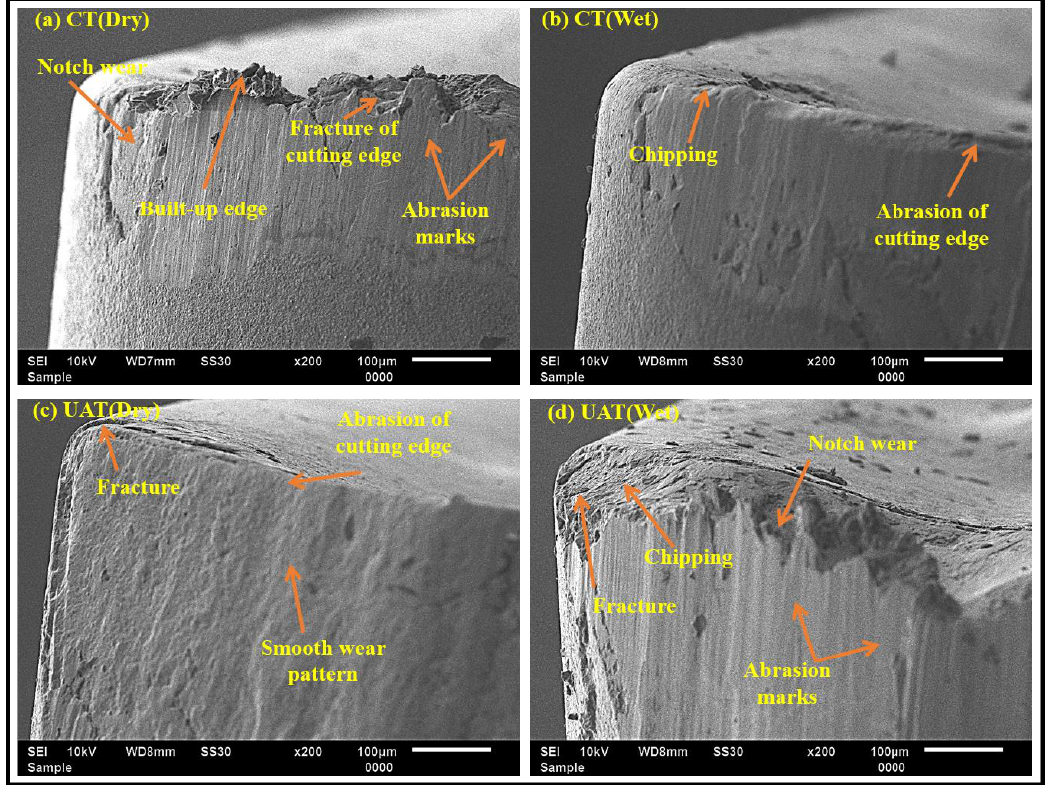
Figure 6. The behaviour of flank wear observed by scanning electron microscope ( V = 50 m/min, f = 0.2 mm/rev, a = 0.4 mm).